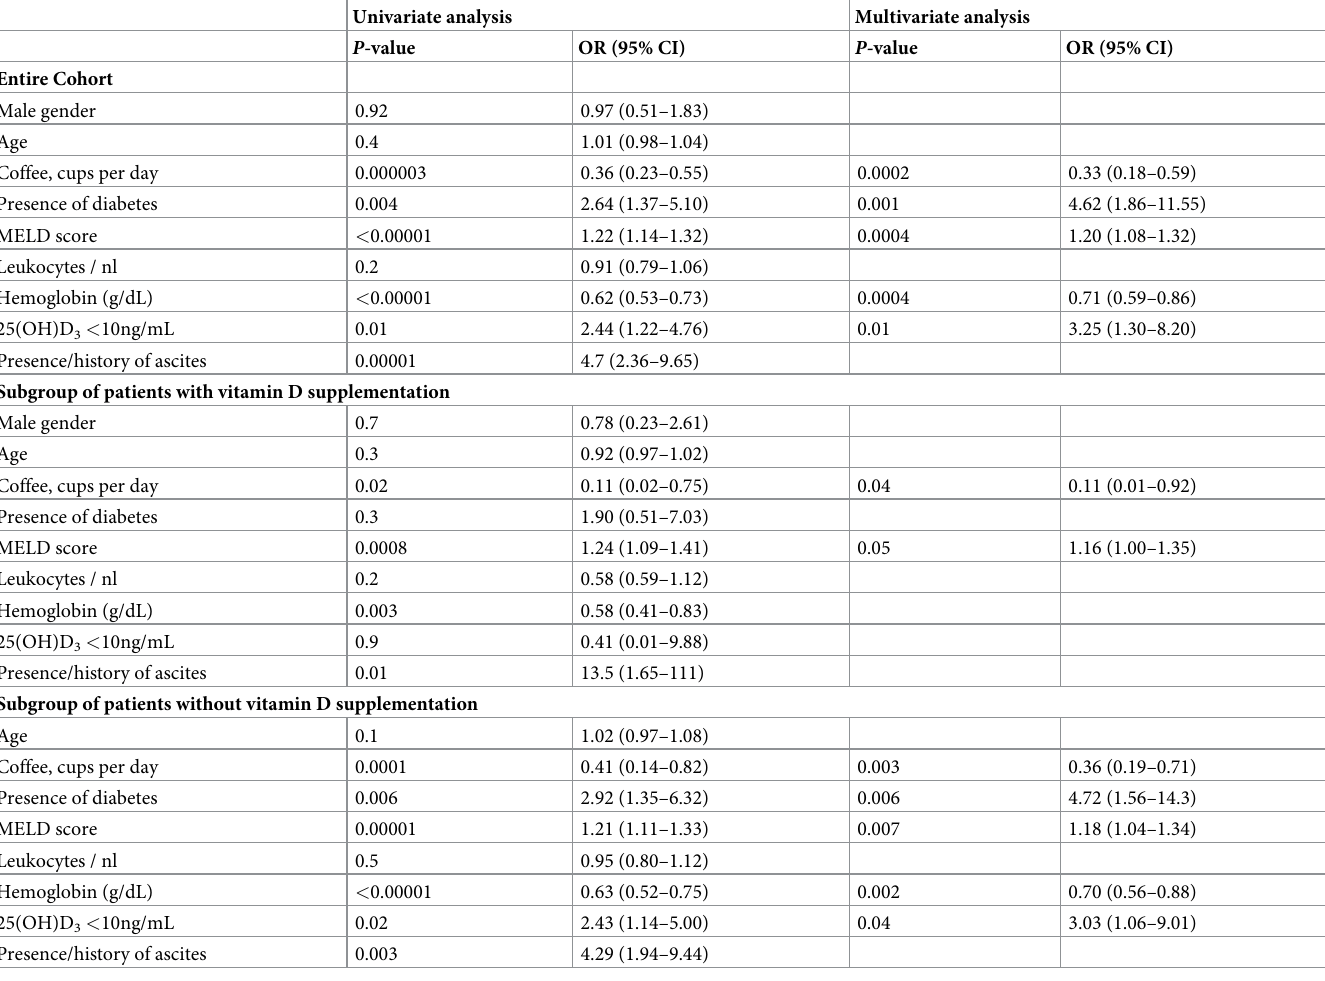
Table 4. Logistic regression analyses of hepatic decompensation in patients with liver